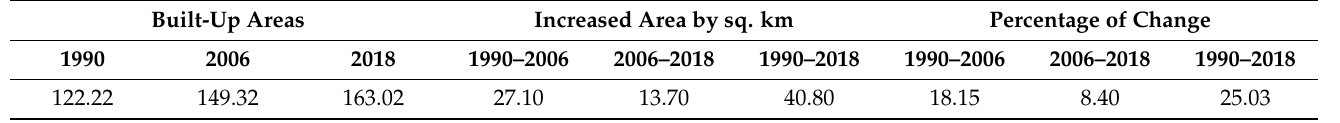
Figure 3 . LULC maps and urban areas extracted from classified images for years 1990, 2006, and 2018. As shown in Table 4, urban areas during the 28 years increased by 40.80 sq. km (+25.03% change) in Tallinn and its 15 km buffer zone. Urban expansion during 1990–2006 was 27.10 sq. km (18.15% increase), faster than the expansion of urban areas between 2006 and 2018, which was 13.70 sq. km and a rise of 8.40% in this timestamp. Table 4. Urban expansion in Tallinn and its buffer zone from 1990 to 2018. Built-Up Areas Increased Area by sq. km Percentage of